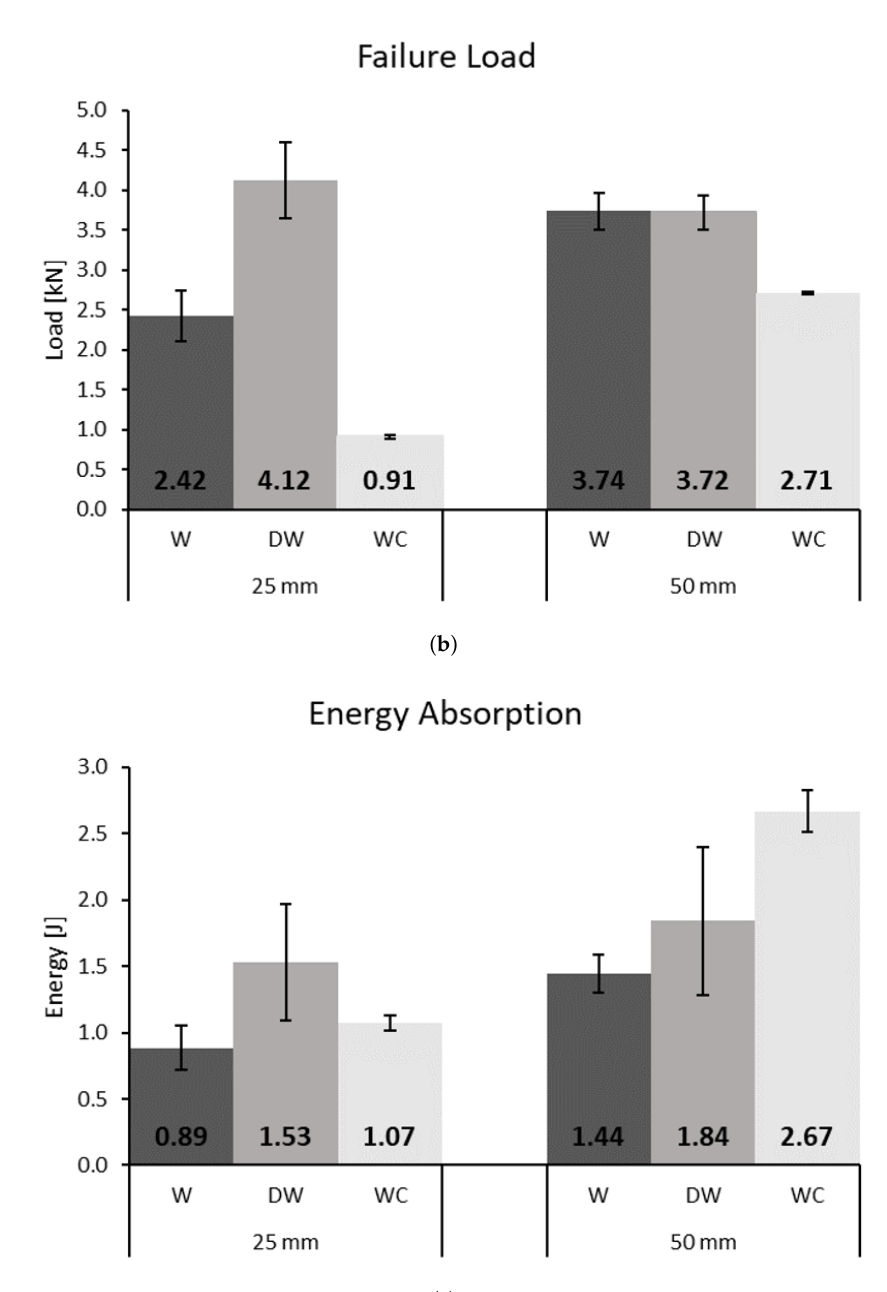
Figure 15. Summary of results. ( a ) Representative curves for all test conditions. ( b ) Summary of failure loads for each joint configuration and overlap length. ( c ) Summary of energy absorption values for each joint configuration and overlap